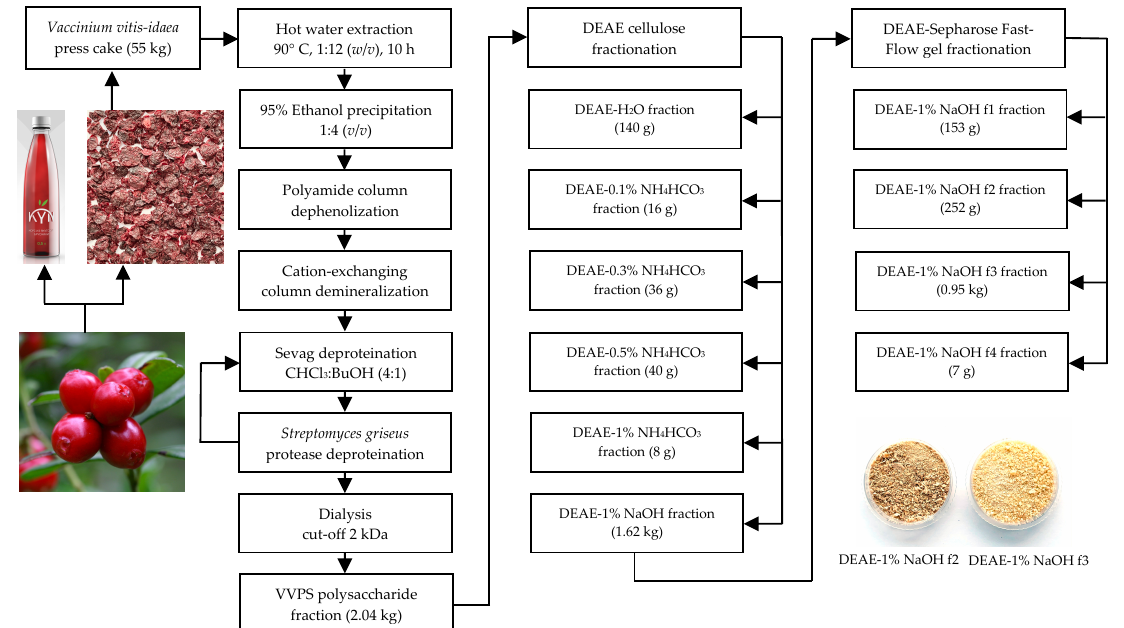
Figure 1. Flow chart for the extraction and fractionation of polysaccharides from Vaccinium vitis- Figure 1 . The flow chart for the extraction and fractionation of polysaccharides from V. vitis idaea press cake. idaea press cake. Abbreviation used: VVPS, V. vitis-idaea total polysaccharide fraction; DEAE, di- ethylaminoethyl cellulose; DEAE–sepharose fast-flow gel, diethylaminoethyl cellulose sepharose fast-flow